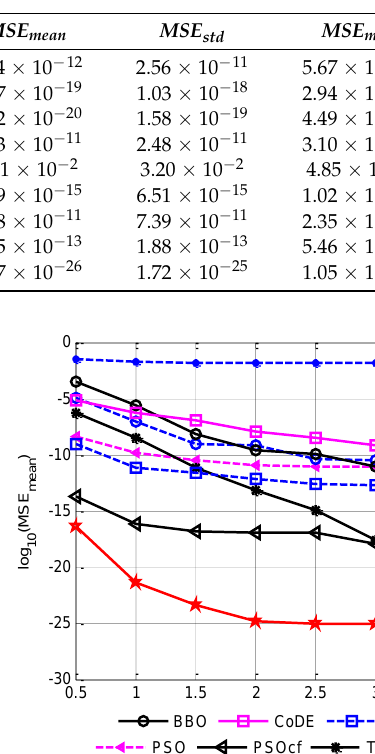
Table 8. Experimental results for the Balloon dataset.